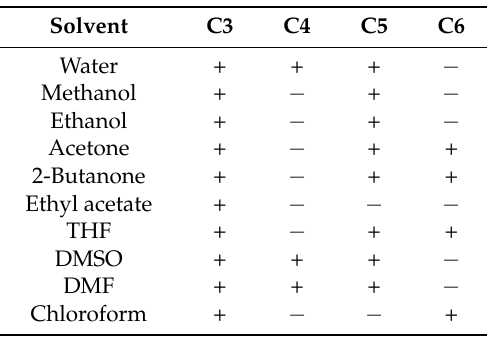
Table 3. Solubility of imidized C3 and quaternized C4, C5, and C6 in chosen solvents (10 mg of copolymer/mL). (+) well soluble (>10 wt %); ( − ) nonsoluble (<1 wt %).